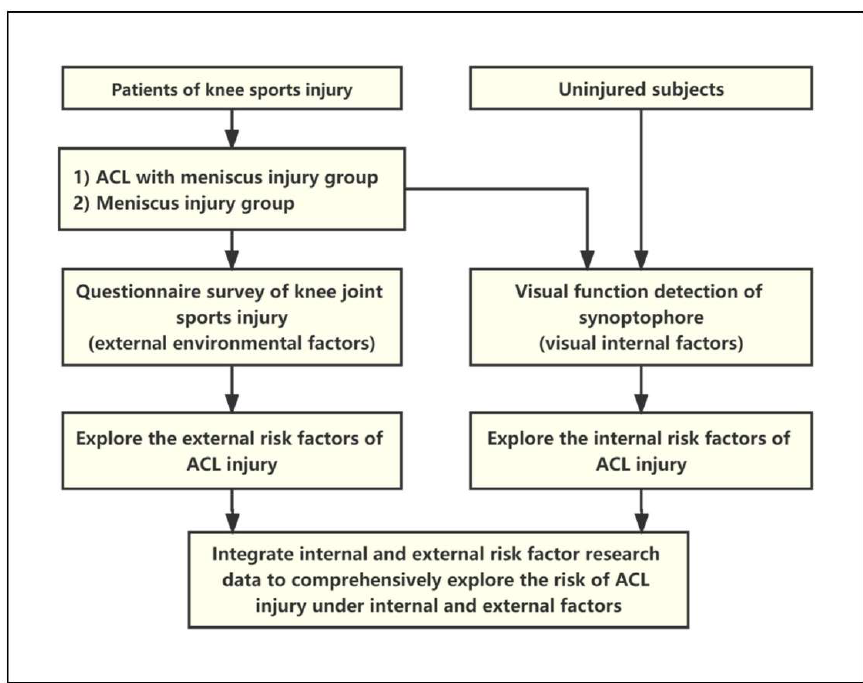
Figure A1. Flow chart 2: Research design and data analysis process.